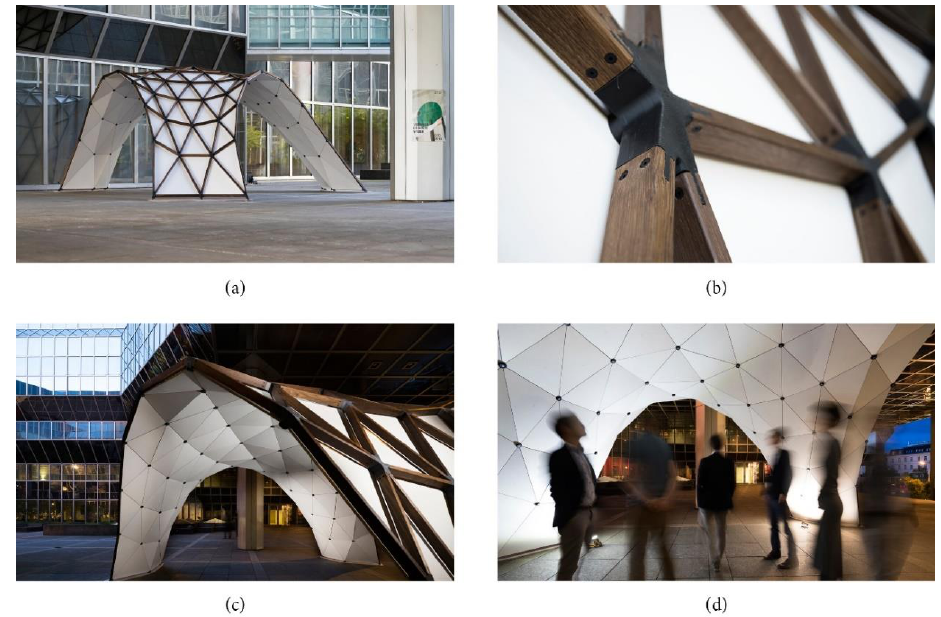
Figure 14. Prototype Optiknot 3D © Christoph Panzer: ( a ) View from outside; ( b ) knot detail; ( c ) evening view; ( d ) view from